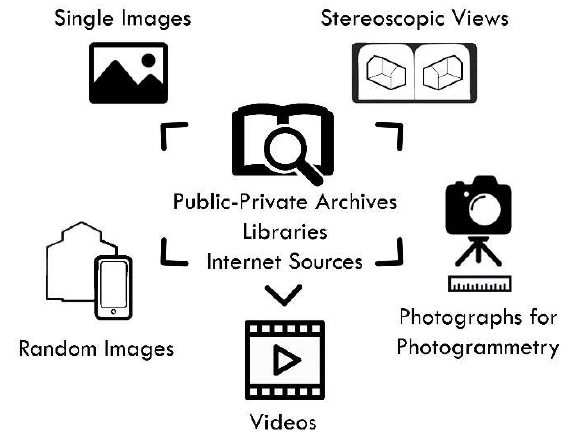
Figure 1. Classification of historical images in five categories